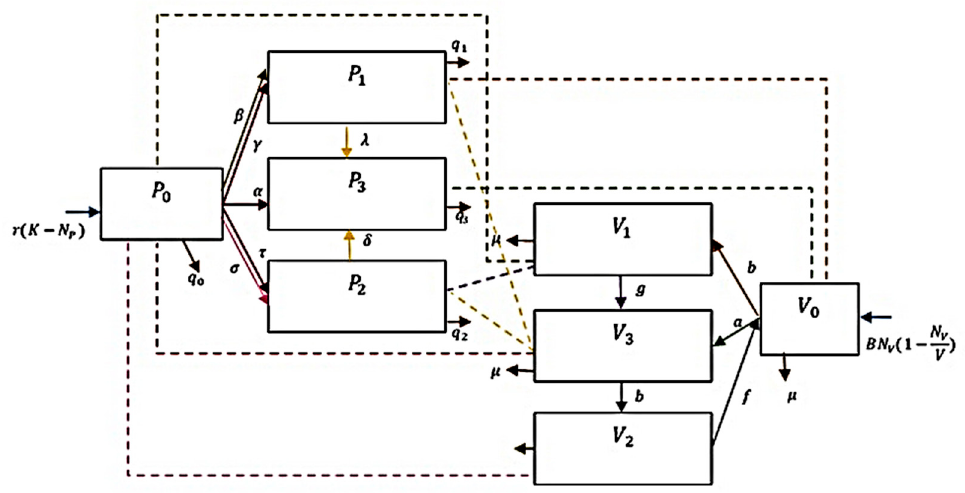
Figure 2. Schematic diagram of the model for the spread of tungro virus disease in rice plants carried out by Blas in 2016 [21].